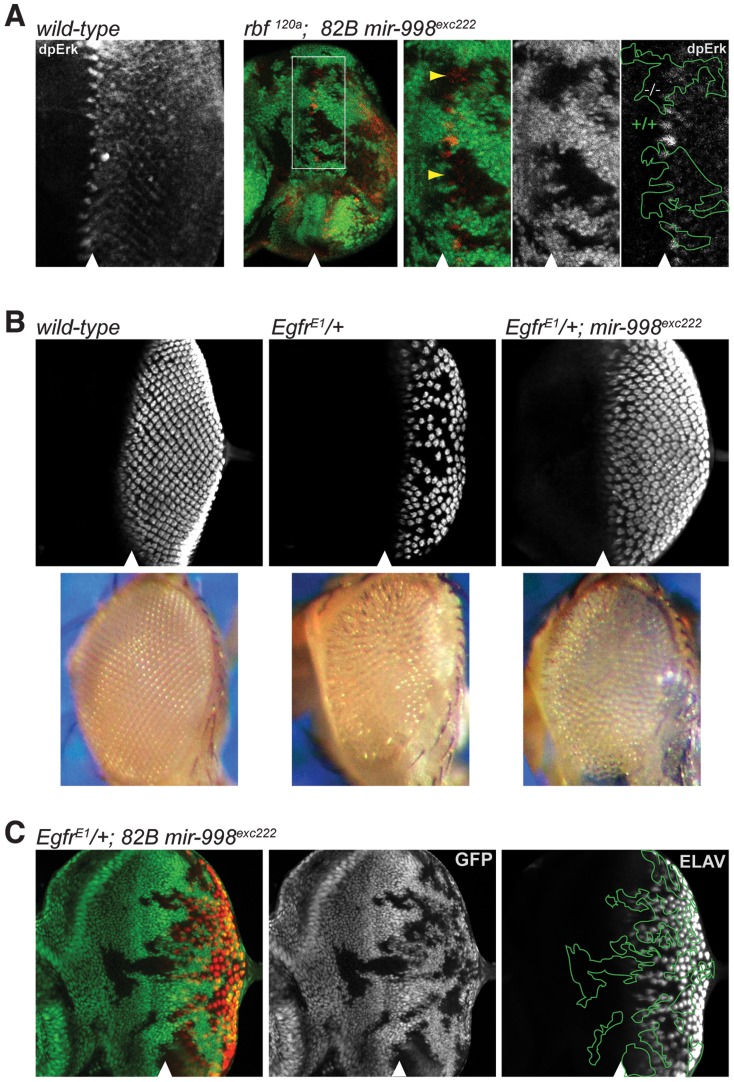

mir-998exc222 suppresses EGFR signaling.(A) Third instar larval eye discs were dissected, fixed, and stained with an antibody recognizing active Erk (dpErk). A wild-type larval eye disc is shown in the left-most panel. To the right: clones of mir-998exc222 mutant tissue were generated using ey-FLP in rbf 120a hemizygous animals as in Fig. 2C. The full disc as well as a higher magnification are shown. Mutant clones were outlined and wild-type mir-998 was indicated by +/+, and −/− for mir-998exc222. Yellow arrowheads show regions in mir-998 mutant tissue with significantly less dpERK staining than expected. (B) Third instar larval eye discs were harvested from wild-type control, EgfrElp/+, and EgfrElp/+; 82B mir-998exc222 animals. Dissected tissue was fixed and stained with an antibody recognizing ELAV (red), which is expressed in photoreceptor clusters. Below are images of adult eyes from wild-type control, EgfrElp/+, and EgfrElp/+; 82B mir-998exc222 animals. Images were taken at the same magnification. (C) Third instar larval eye discs were harvested from ey-FLP; EgfrElp/+; 82B mir-998exc222/82B GFP animals. Tissue that is wild-type for mir-998 is marked by GFP (green), while clones of mir-998 mutant tissue are marked by the absence of GFP. Mutant clones were outlined and wild-type mir-998 was indicated by +/+, and −/− for mir-998exc222. Analysis was performed on a minimum of 10 larvae of each genotype. The position of the morphogenetic furrow is marked with an arrowhead.